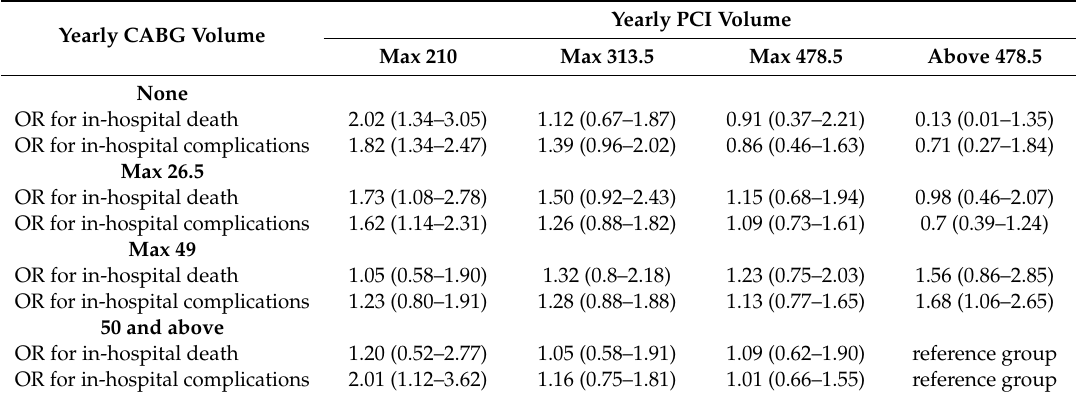
Table 4. Adjusted in-hospital PCI patient risk by its volume; subcategorized by CABG volume in